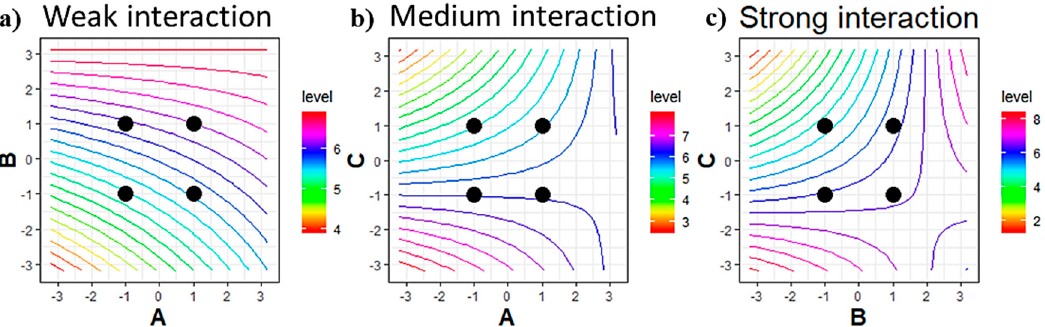
Figure 6. Contour plot for thermoacoustic efficiency. The four black points represent the high and low limits established for each factor, named “Box plot”. Low ( a ), medium ( b ), and strong ( c ) interdependencies are detected for AB, AC, and BC interactions, respectively.